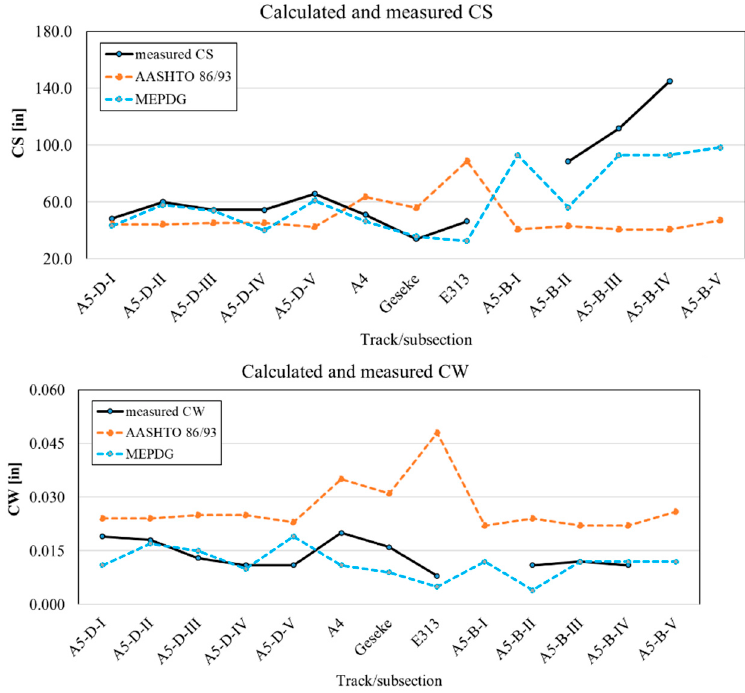
Figure 13. Calculated and measured CS and CW on examined sections.